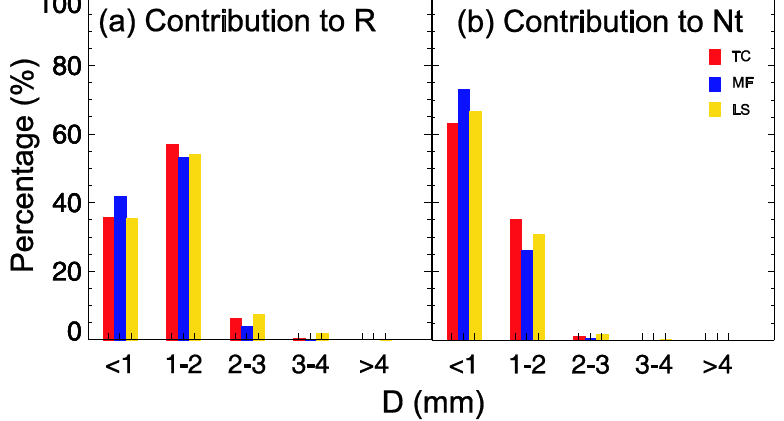
Figure 8. The percentage contribution of various-diameter raindrops to ( a ) R and ( b ) Nt (total number concentration) for the three rain types based on JWD data.